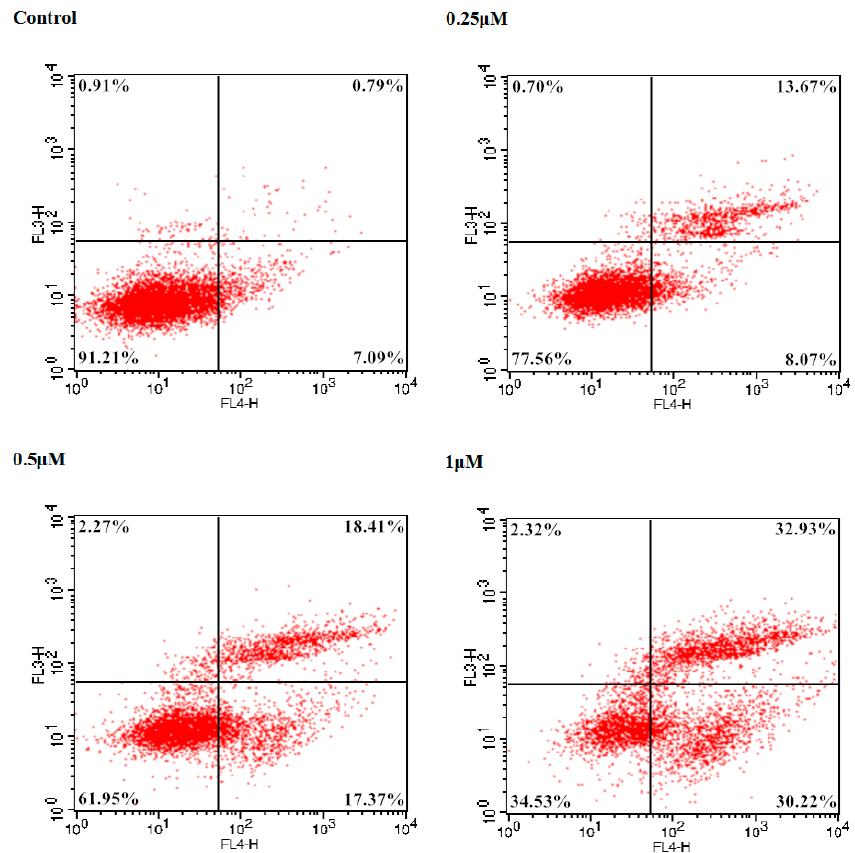
Figure 3. Induction of apoptosis by 9f in Bel-7402 cells.